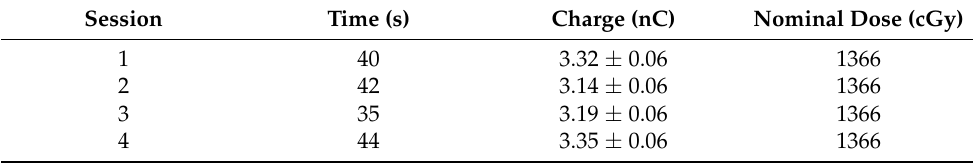
Table 3. Irradiation parameters and results obtained during the patient irradiation